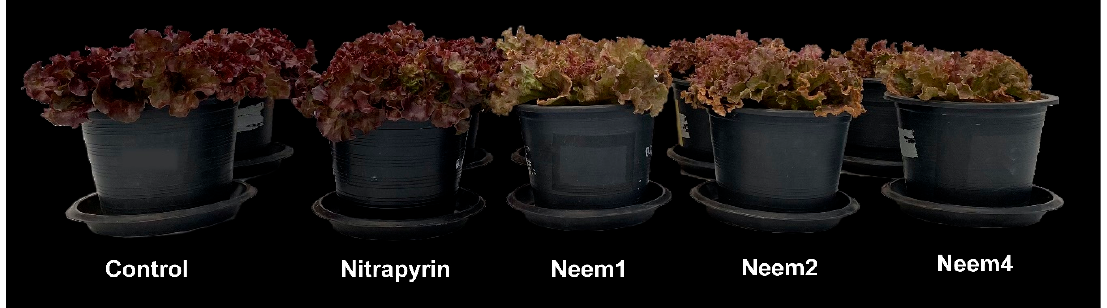
Figure 3. Lettuce responses to different nitrification inhibitors. Neem1, Neem2, and Neem4 = neem leaf extract based on the dry weight of the raw material at rates of 1, 2, and 4 g kg − 1